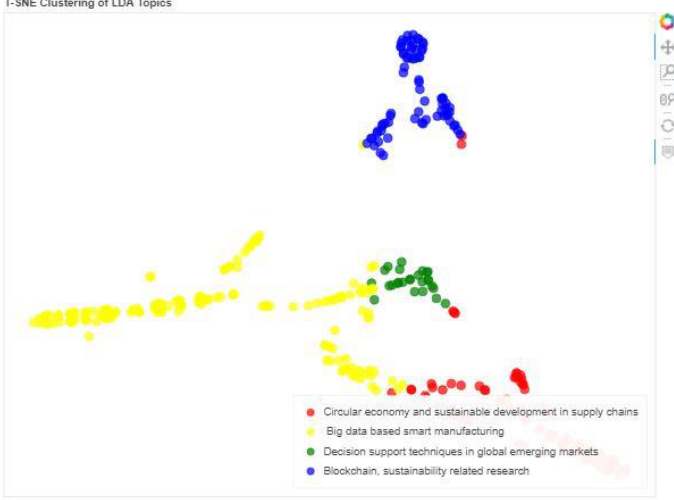
Figure 9. Clustering on “Abstract”.